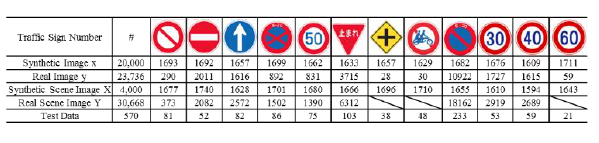
Table 1. The number of Samples